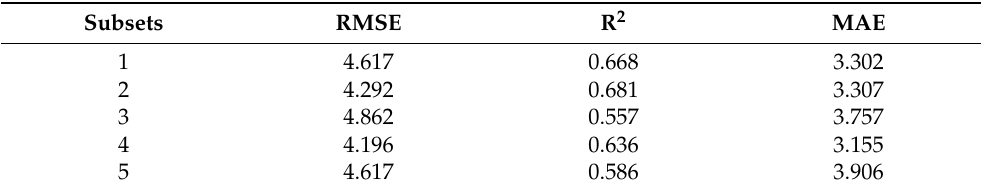
Table 2. The evaluation indices for the 5-fold